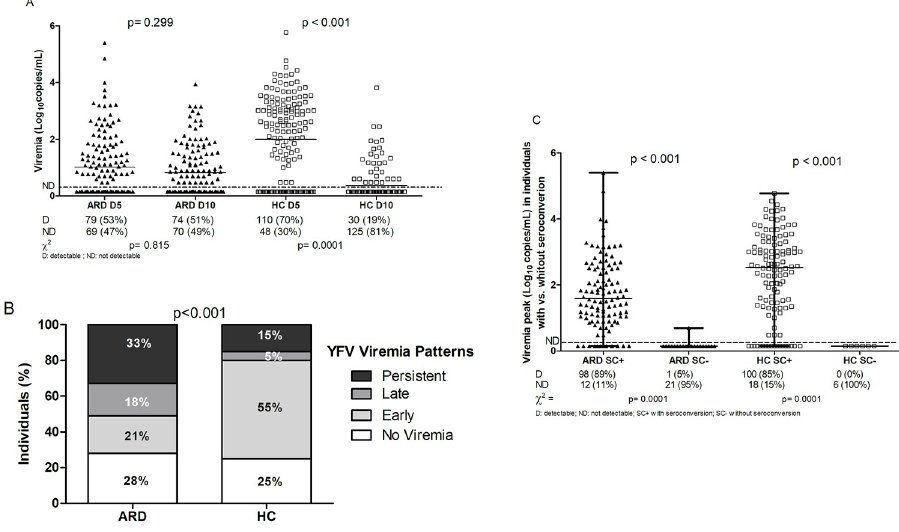
Fig 2. Yellow fever vaccine (YFV) viremia after fractional-dose administration (2A and 2B) in ARD patients and healthy controls (HC). Peak of viremia in seroconverted (SC+) and non-seroconverted (SC-) ARD patients and healthy controls(HC)